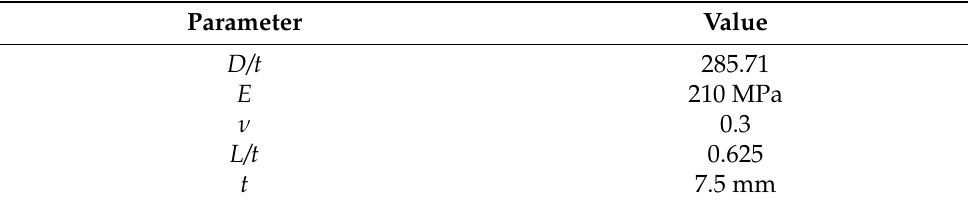
Table 5. Data used in the comparison of the local instability analysis methods of